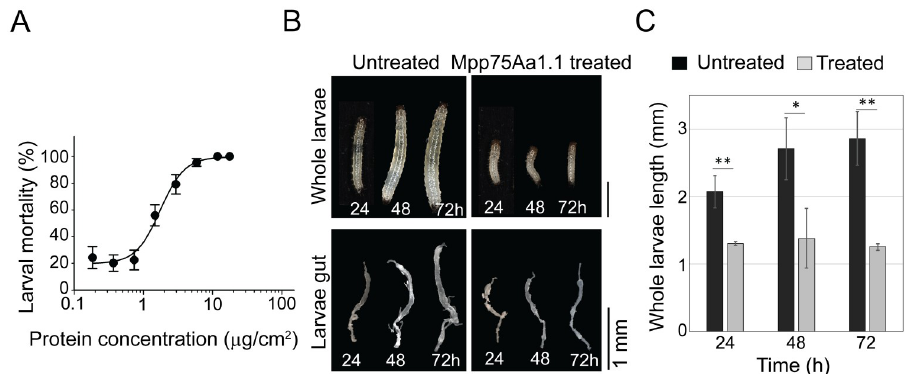
Fig 5. Effects of Mpp75Aa1.1 on WCR larvae development and dissected gut morphology. (A) Insecticidal activity of Mpp75Aa1.1 measured by increasing protein dose. Data points represent mean mortality ( ± S.E.), not corrected for buffer control mortality (4.75% ± 4.76). (B) Whole insect growth inhibition and isolated gut morphology assessments after 24 h, 48 h, and 72 h exposure to Mpp75Aa1.1. Significant insect stunting observed as early as 24 h post-exposure. (C) Bar graph representation of growth inhibition. Asterisks indicate statistical significance at p = 0.05 ( � ) and p = 0.01 ( �� ) using the student t-test (n = 5).